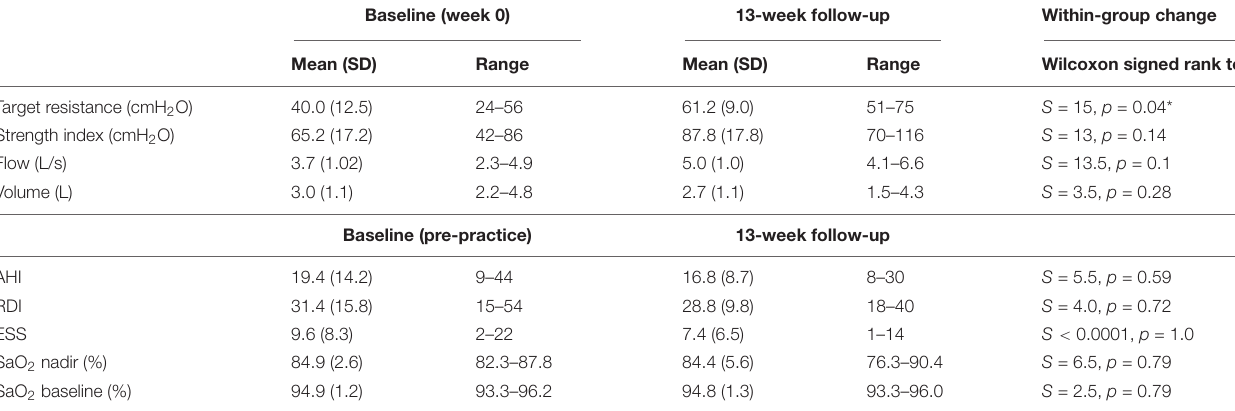
TABLE 2 | Descriptive statistics and within-group change of IMT device data from baseline to follow-up.